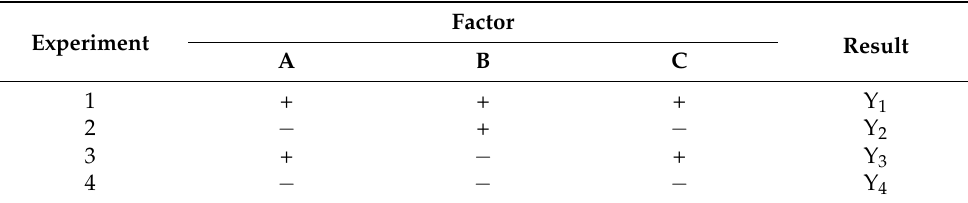
Table 4. The partial factorial model for testing the robustness of the analytical method.